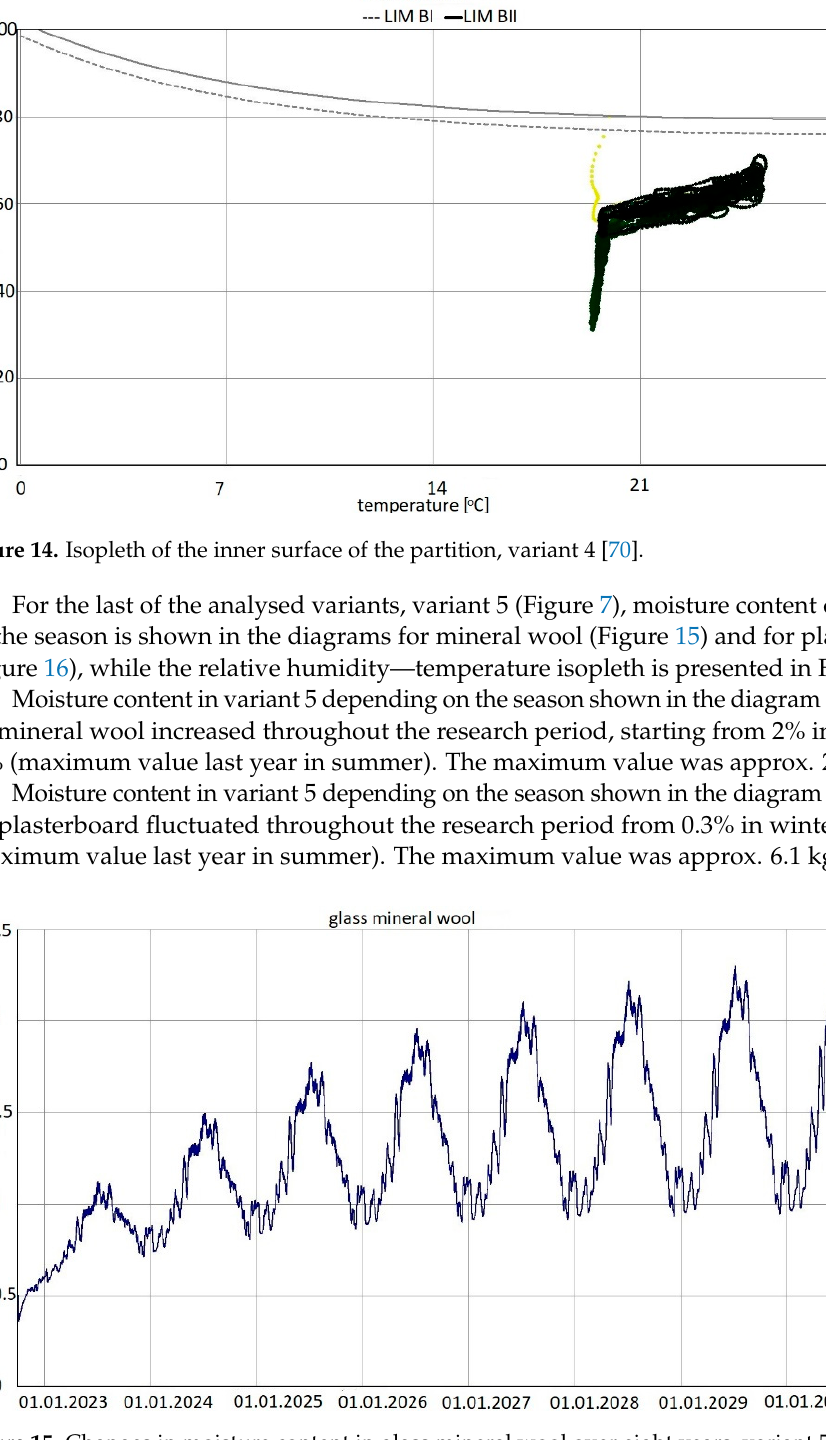
Figure 13. Changes in moisture content in plasterboard over eight years, variant 4 [70].